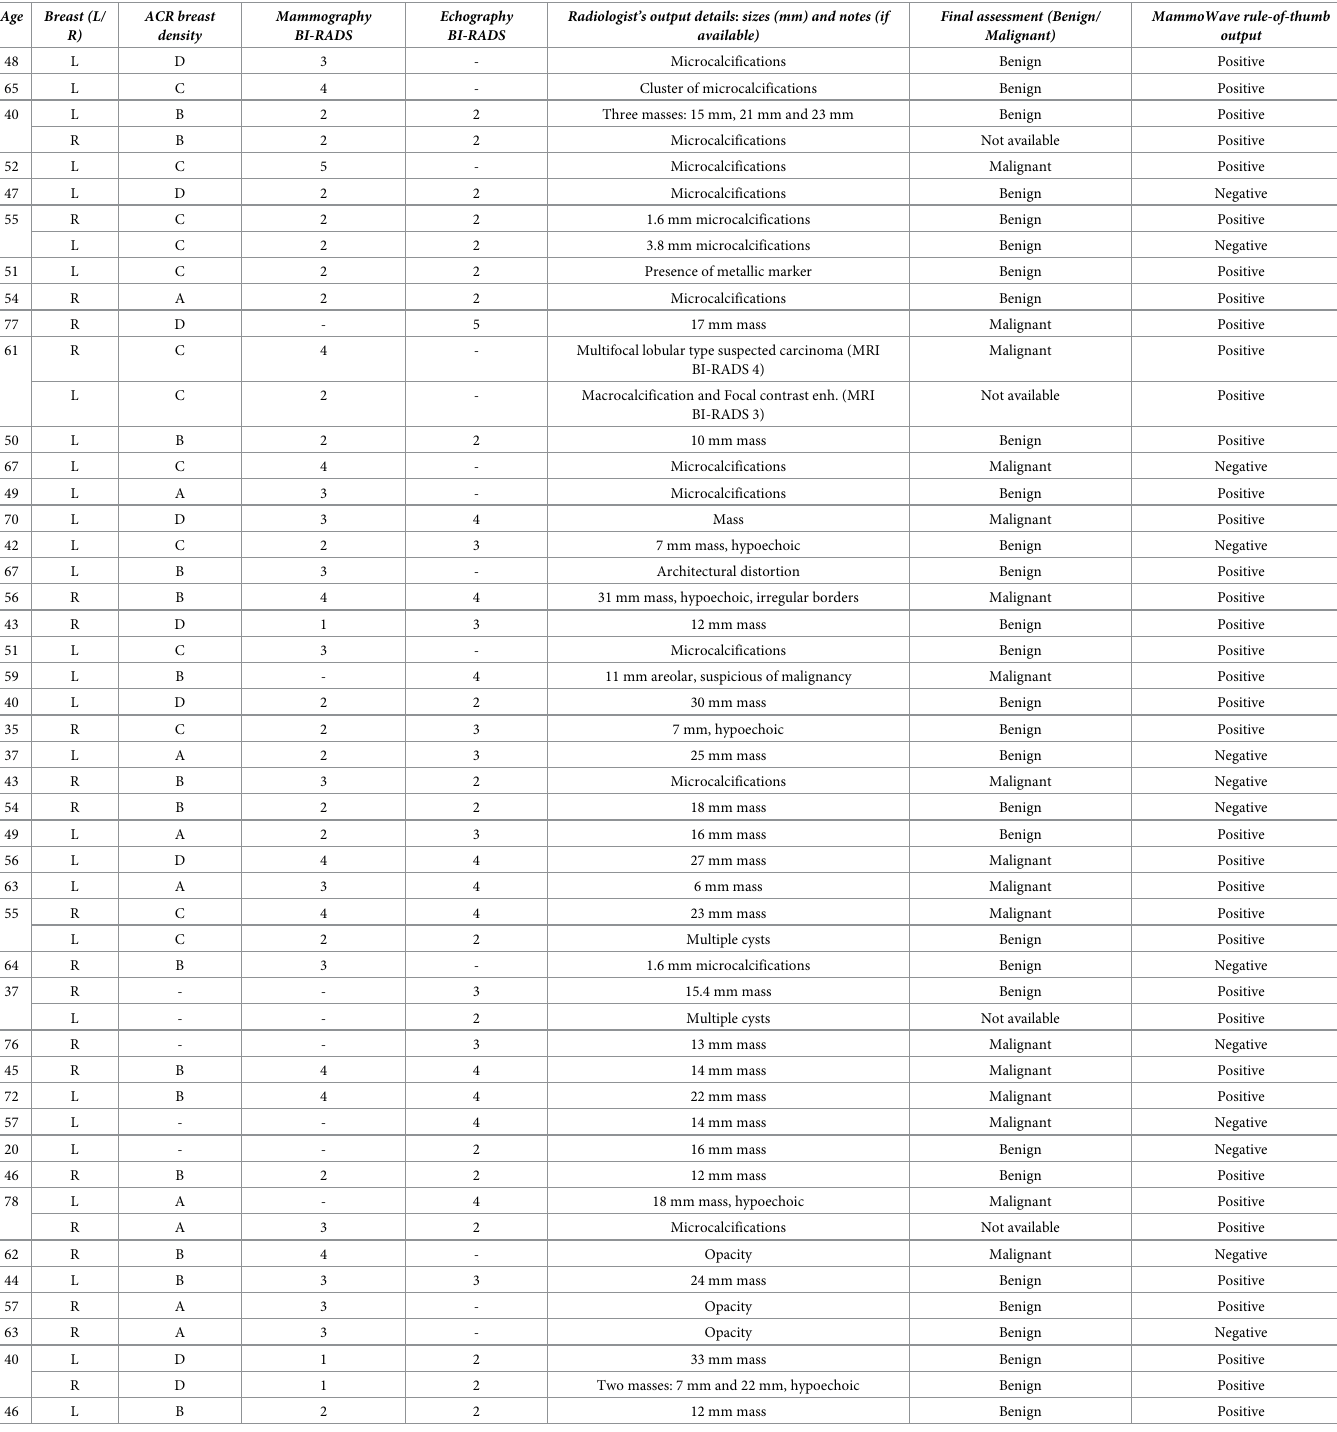
Table 3. Details of the radiological study review are given for the 51 WF breasts: Age, left (L) or right (R) breast, ACR breast density, mammography/echography BI-RADS, radiologist’s output details such as sizes (mm) and notes (if available), final assessment (Benign/Malignant) obtained using pathology and/or at least one year of clinical follow-up as reference standards (if